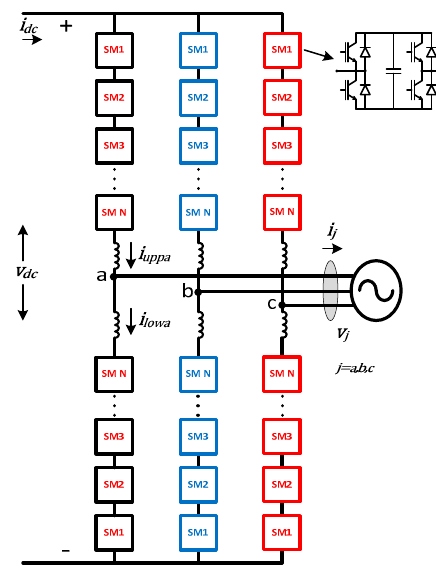
Figure 3. MMC topology with FBSM. SM: submodule.